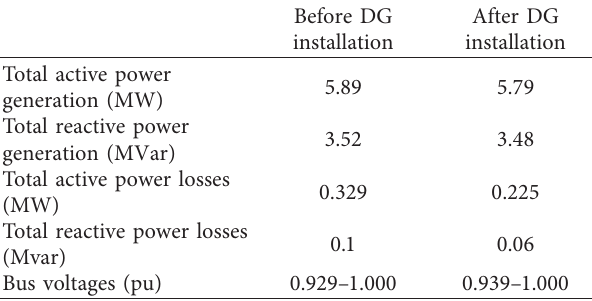
Table 1: Comparison between network status before and after DG installation.